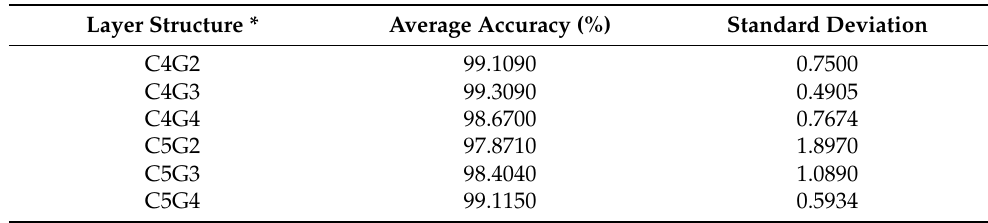
Table 3. The classification results according to changes in the number of GRU layers of the 1D CNN–GRU.